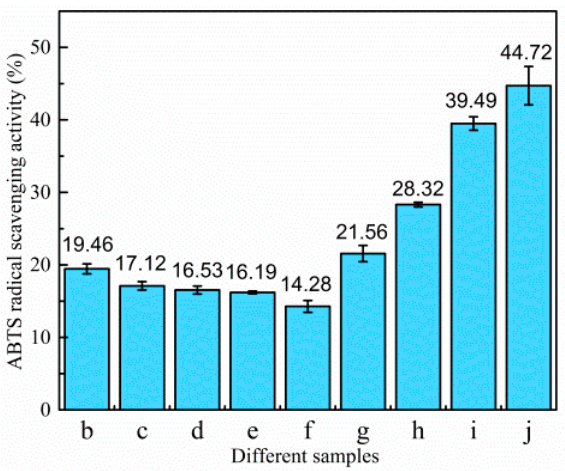
Figure 9. ABTS radical scavenging activity. ( b ) Control film; ( c ) 1% TiO 2 -N; ( d ) 3% TiO 2 -N; ( e ) 5% TiO 2 -N; ( f ) 7% TiO 2 -N; ( g ) 3% CO-3% TiO 2 -N; ( h ) 6% CO-3% TiO 2 -N; ( i ) 9% CO-3% TiO 2 -N; and ( j ) 12% CO-3% TiO 2 -N.